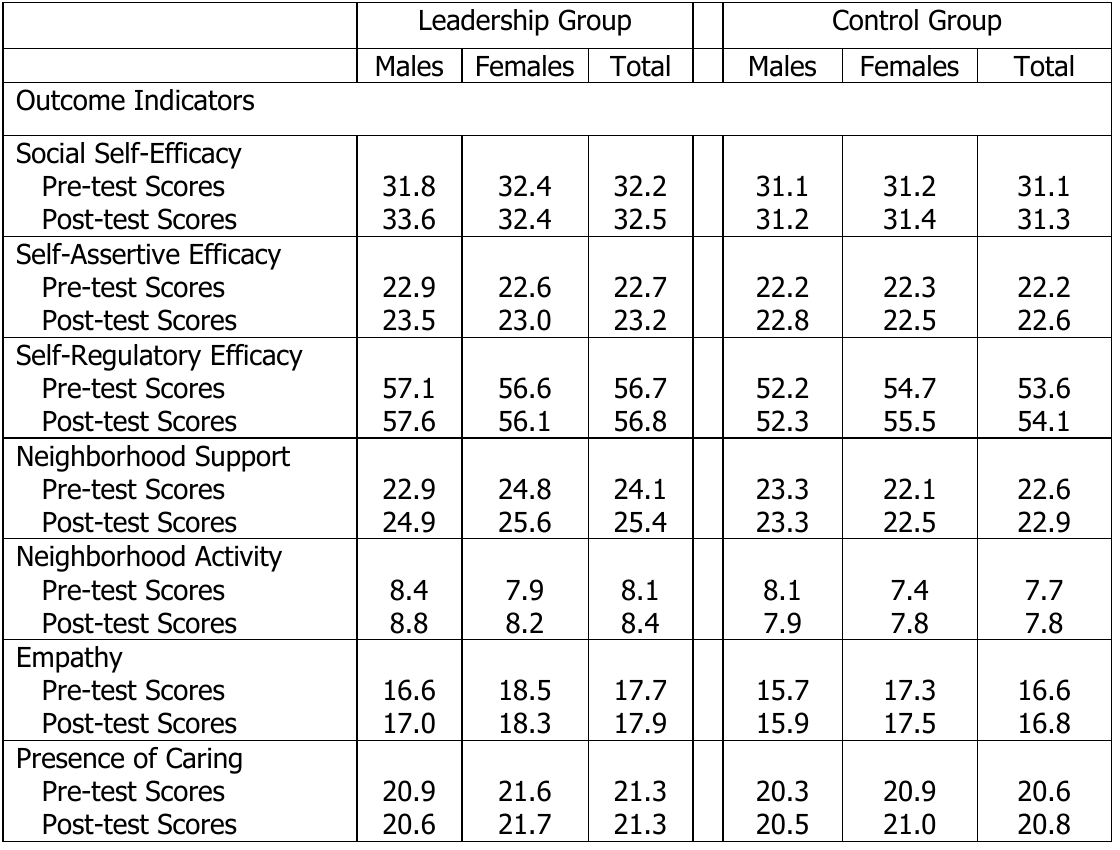
Mean scores on pre-test and post-test outcome measures for males and females in leadership and comparison groups Leadership Group Control Group Males Females Total Males Females